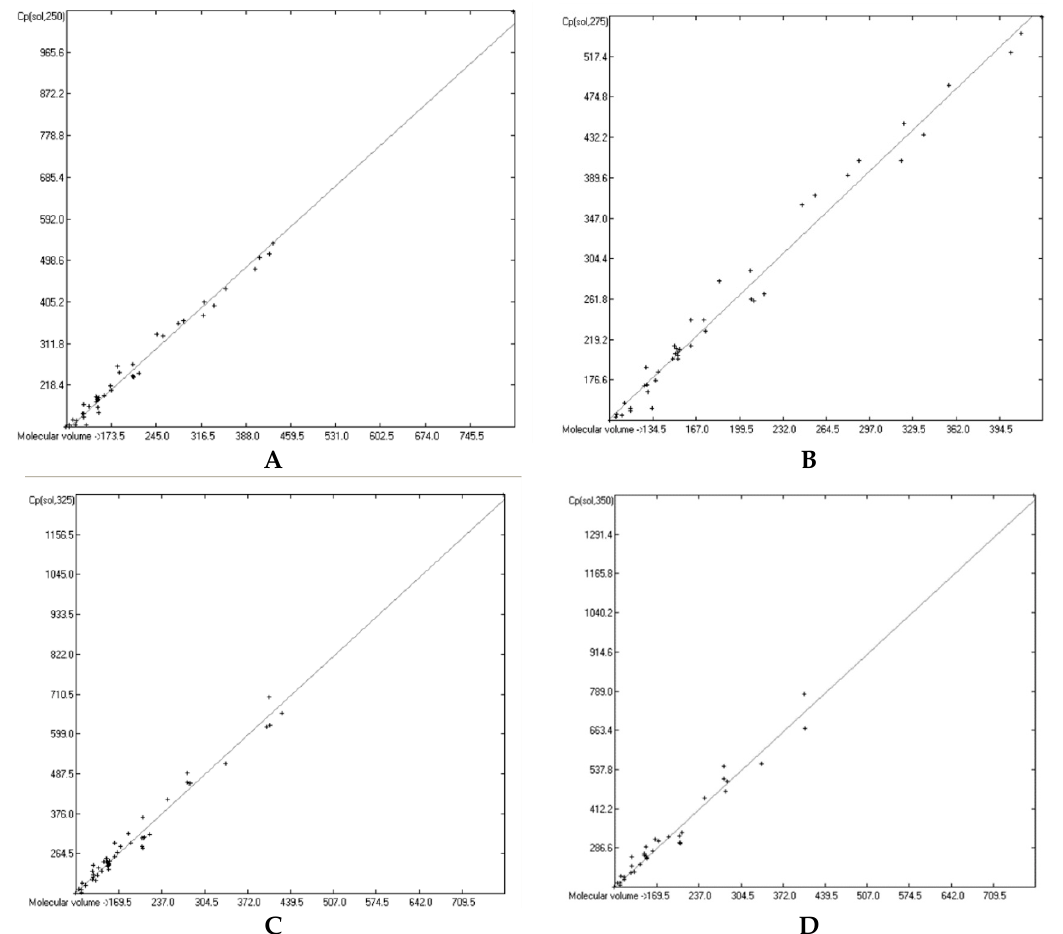
Figure 18. Correlation of molecular volumes with solid heat capacities of OH-carrying compounds at various temperatures. ( A ): 250 K. ( B ): 275 K. ( C ): 325 K. ( D ): 350 K. Table 15. Statistics of liquid heat capacities of OH-free compounds at various temperatures. Table 18. Statistics of solid heat capacities of OH-carrying compounds at various temperatures. Cp at Various K